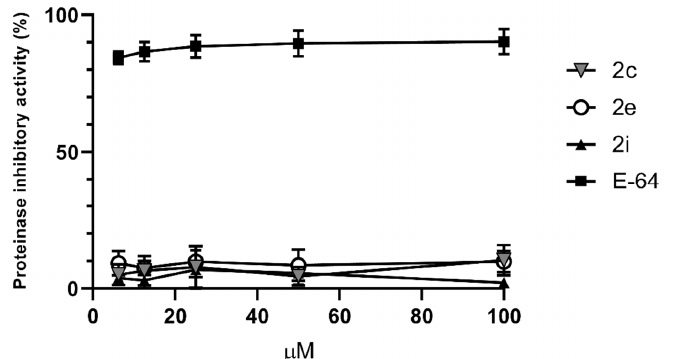
Figure 10. Analysis of the inhibitory activity of promising compounds on T. cruzi cysteine proteases. Protein extracts (5 μ g) of trypomastigote forms of T. cruzi were incubated with a series of dilutions (100–6.25 μ M) of pyrazole ‐ thiazoline derivatives ( 2c , 2e , and 2i ) and E ‐ 64, a specific inhibitor of cysteine proteases. The fluorescent signal resulting from the degradation of the fluorogenic sub ‐ strate Z ‐ FR ‐ AMC (60 μ M) was quantified to determine the enzymatic activity. Results are presented as mean and standard deviation (±) of percent (%) enzyme activity from at least three independent experiments.